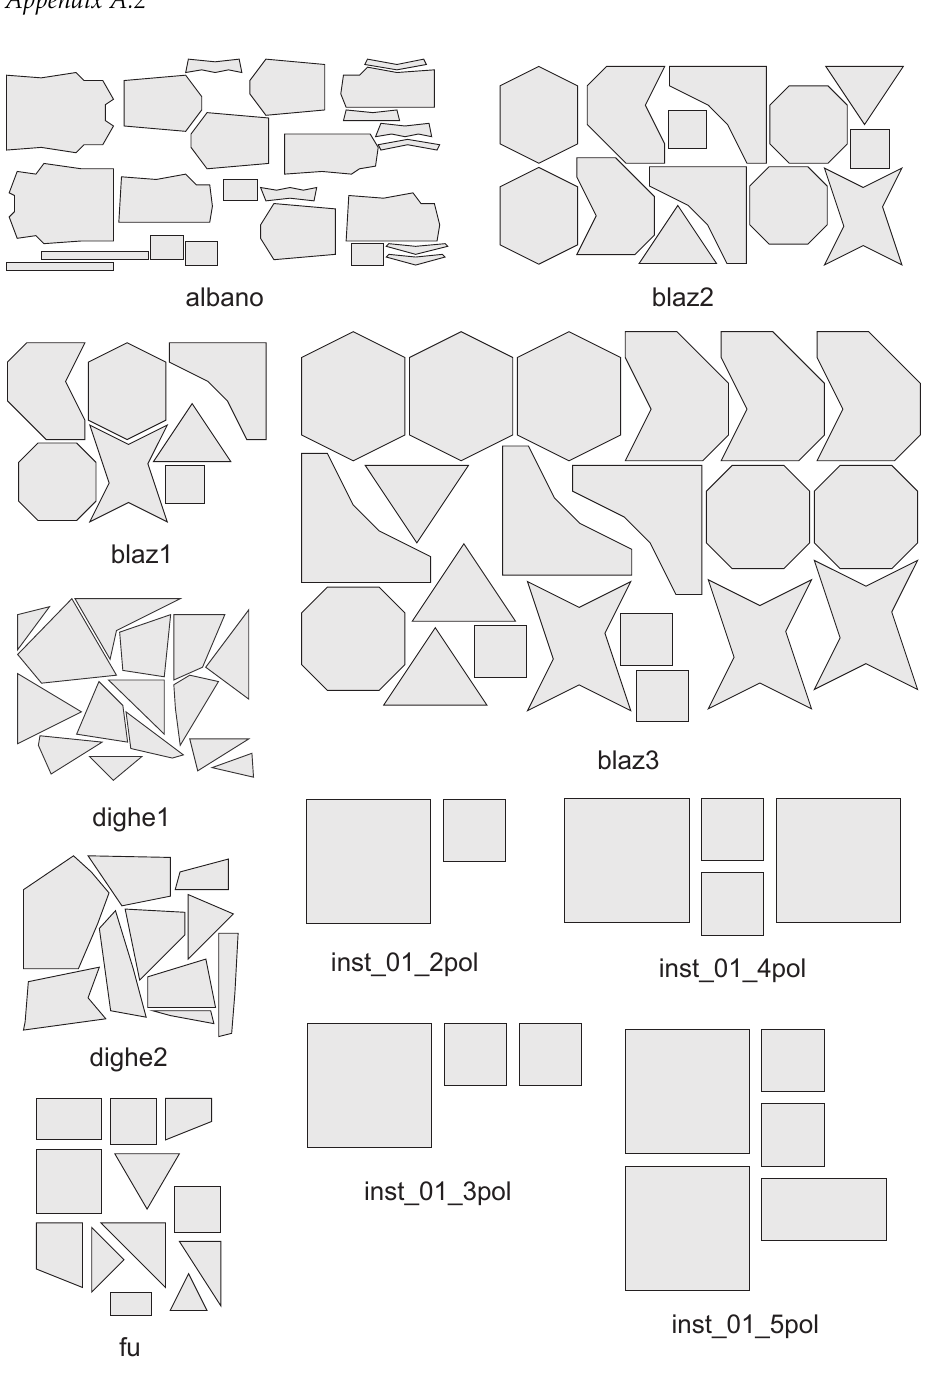
Figure A3. First batch of instances with separated